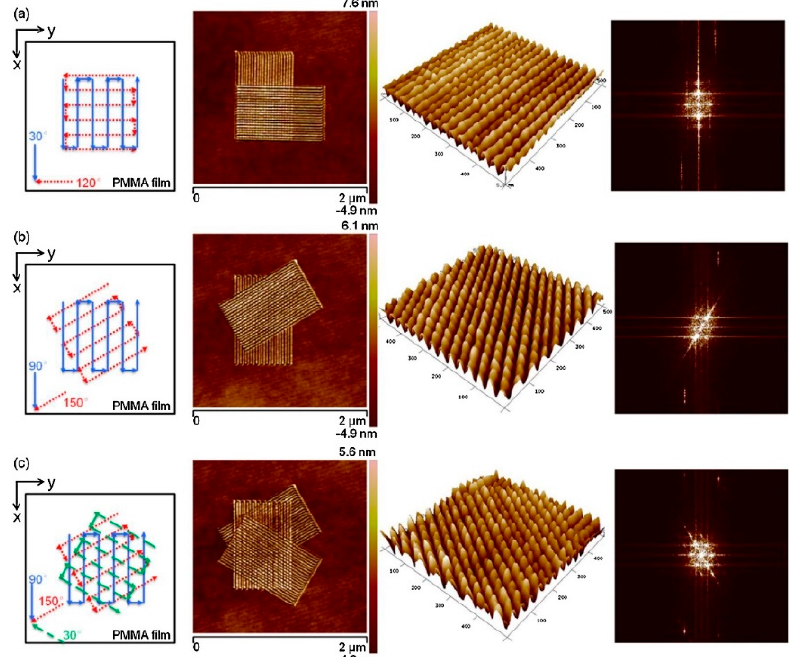
Figure 4. Nanodot arrays fabricated by dynamic plowing lithography (DPL) method: ( a ) checkerboard nanodot arrays fabricated by two-step scanning at 30° and 120°. ( b ) Diamond-shaped nanodot arrays fabricated by two-step scanning at 90° and 150°. ( c ) Hexagonal nanodot arrays fabricated by three-step scanning at 30°, 90° and 150° [81] .